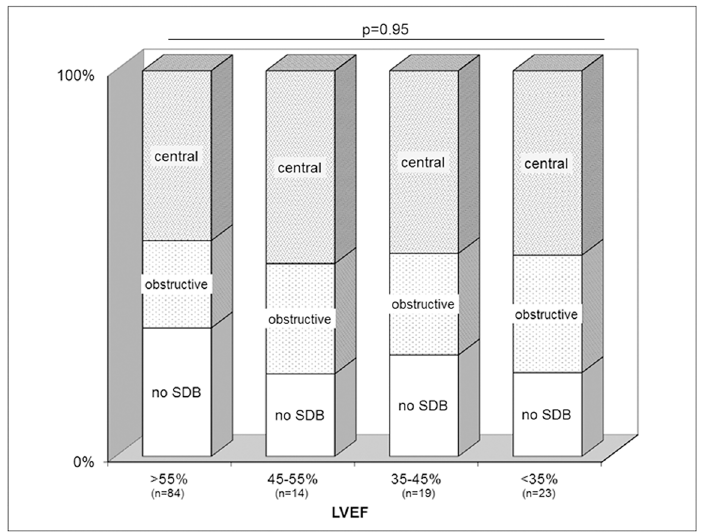
doi:10.1371/journal.pone.0133176.g003